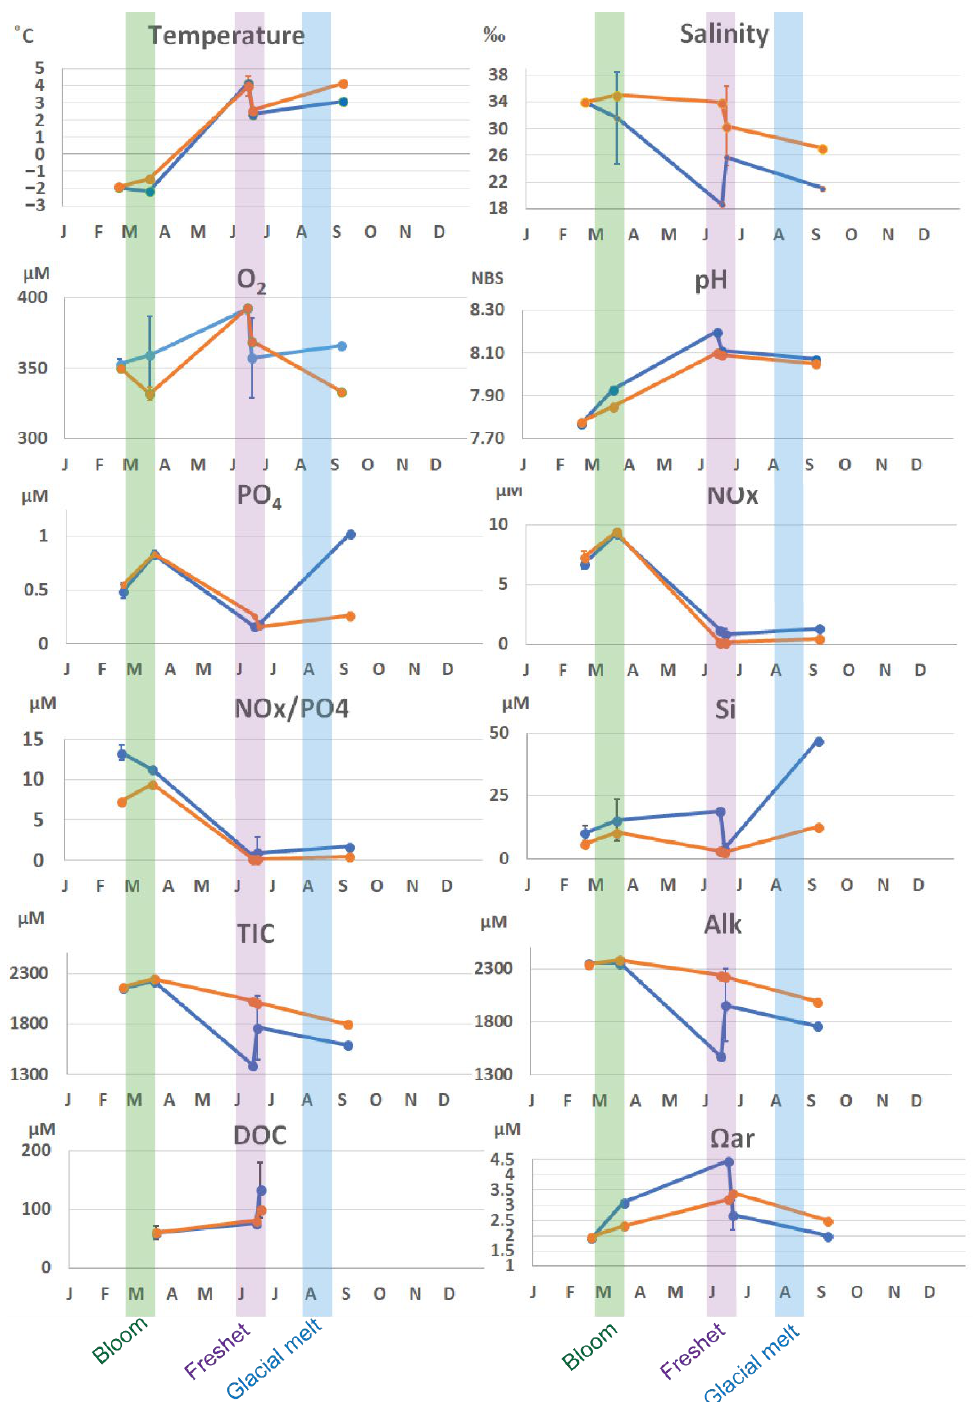
Figure 9. Seasonal variability of concentrations of biogeochemical parameters in the surface layer near the glacier (blue dots and blue line) and in outer Templefjord (orange dots and orange line) detected from February to September (horizontal scale) on expeditions in 2011–2017 (dots correspond to sampling time). Thick colored vertical lines show the typical periods of the spring bloom (green), freshet (pink), and glacial melt (blue). Thin vertical lines outline standard errors.